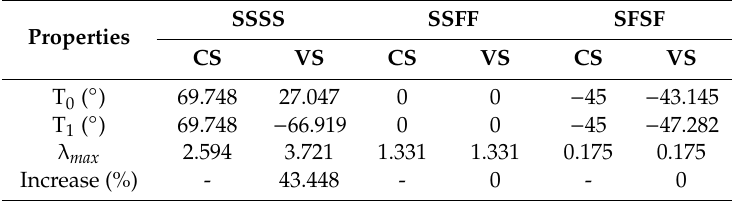
Table 15. Optimal angles of a single layer VS plate for maximum biaxial load multipliers, with simply supported boundary conditions.